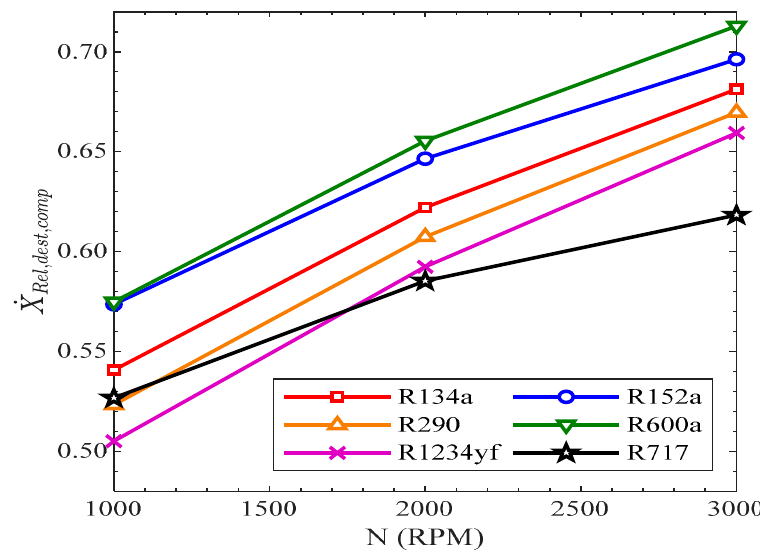
Figure 13. Relative exergy destruction of compressor vs. compressor speed .